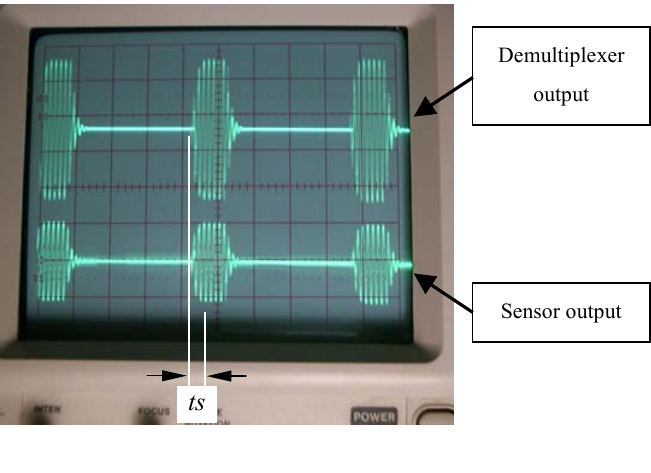
Figure 14. Sinusoidal output waveforms of the demultiplexer and the sensor coil.